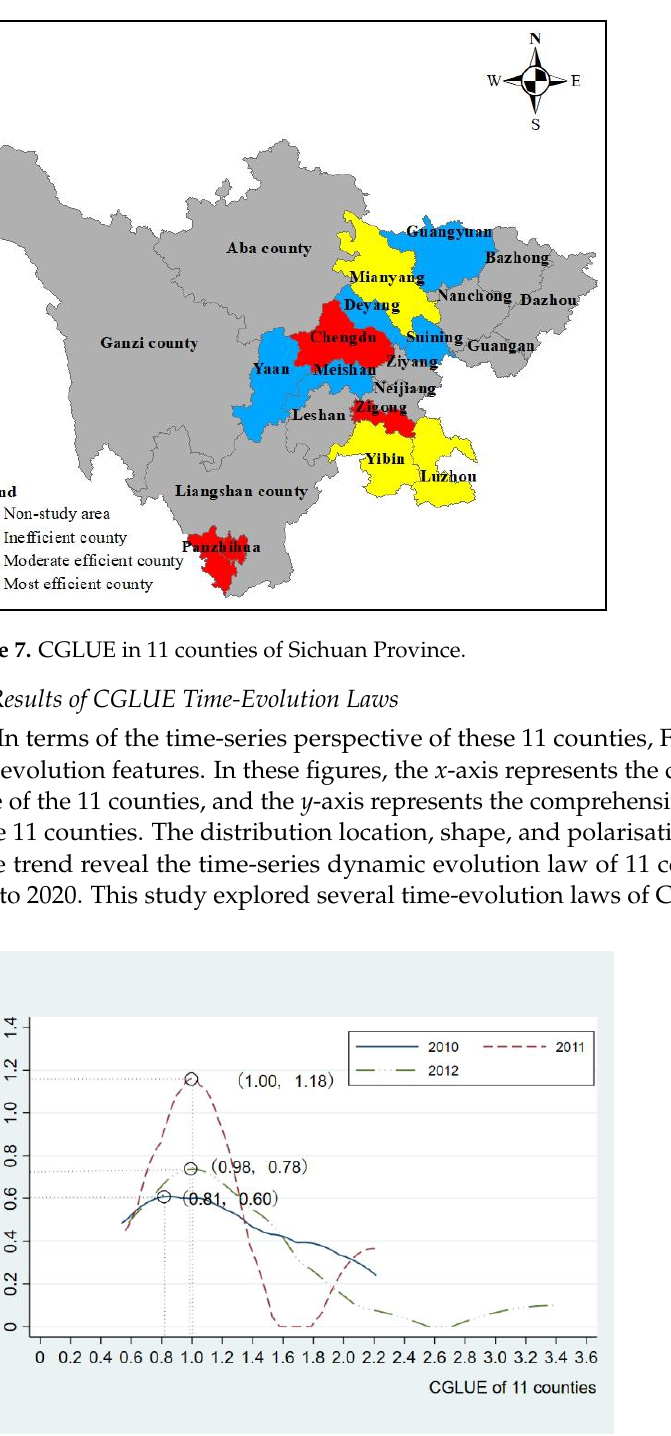
Figure 9. Efficiency kernel density curve from 2013 to 2016.